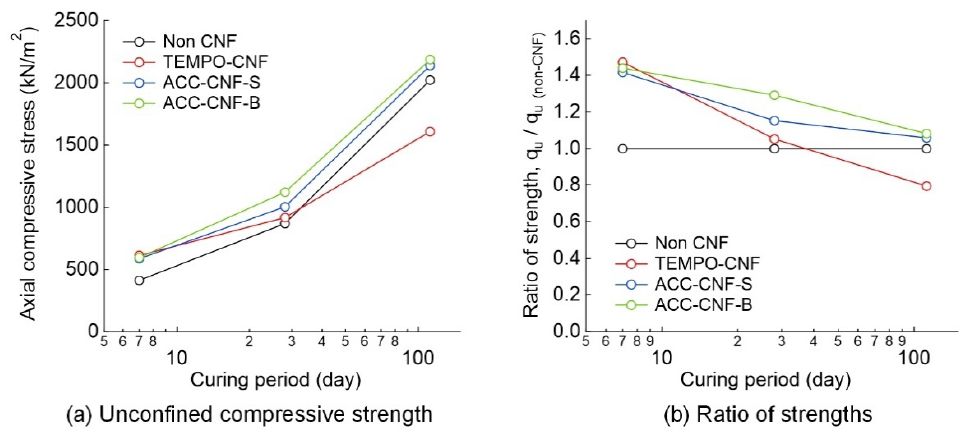
Figure 6. Time change of unconfined compressive strength (Method 1).